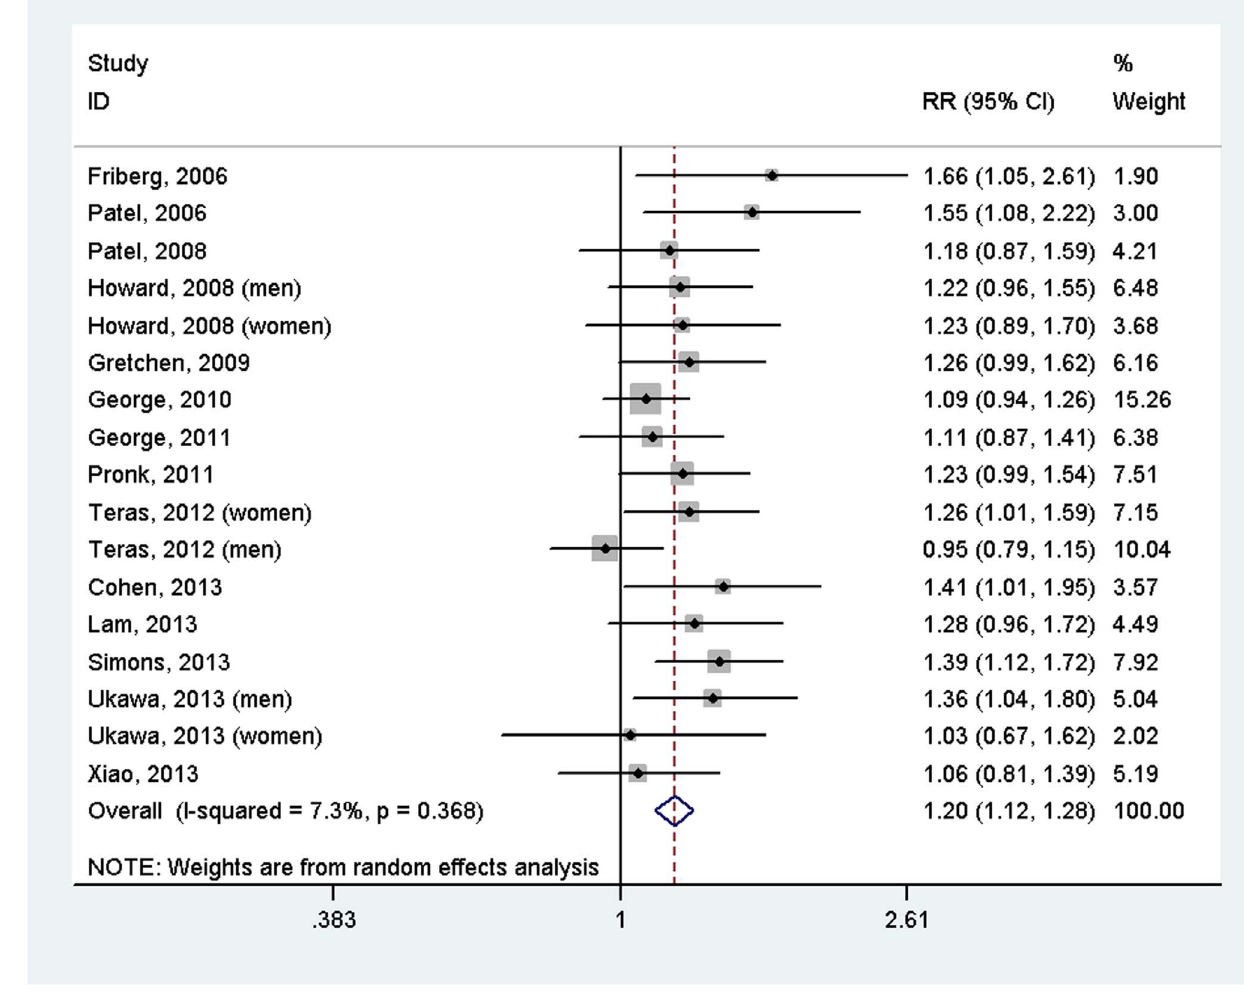
Figure 2. Forest plot of the association between sedentary behavior and risk of incident cancer (highest versus lowest level).